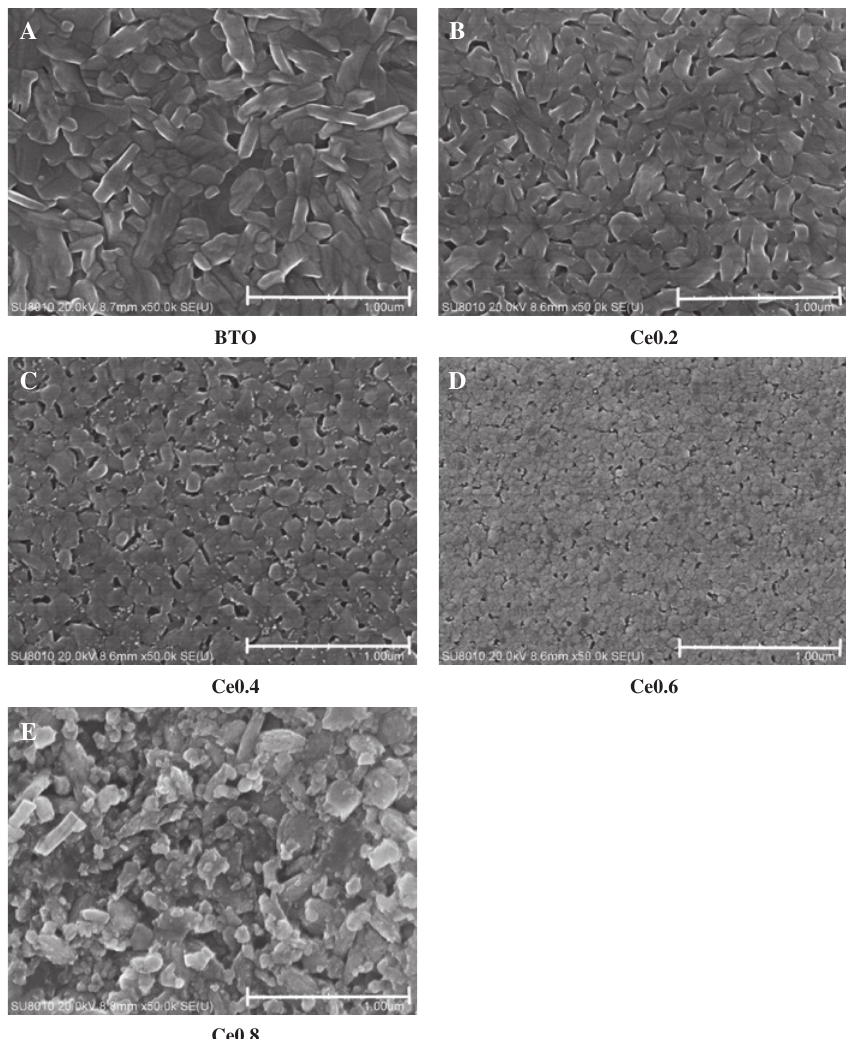
Figure 1 FE-SEM images of BCeT films sample annealed at 700 °